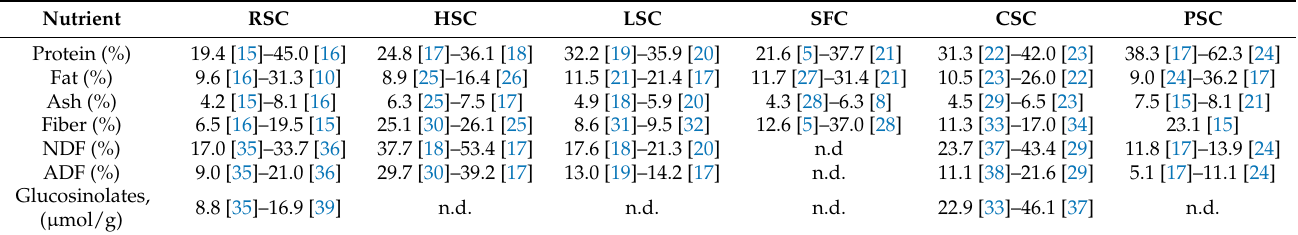
Table 1. Chemical composition (on DM basis) of cold-pressed oilseed